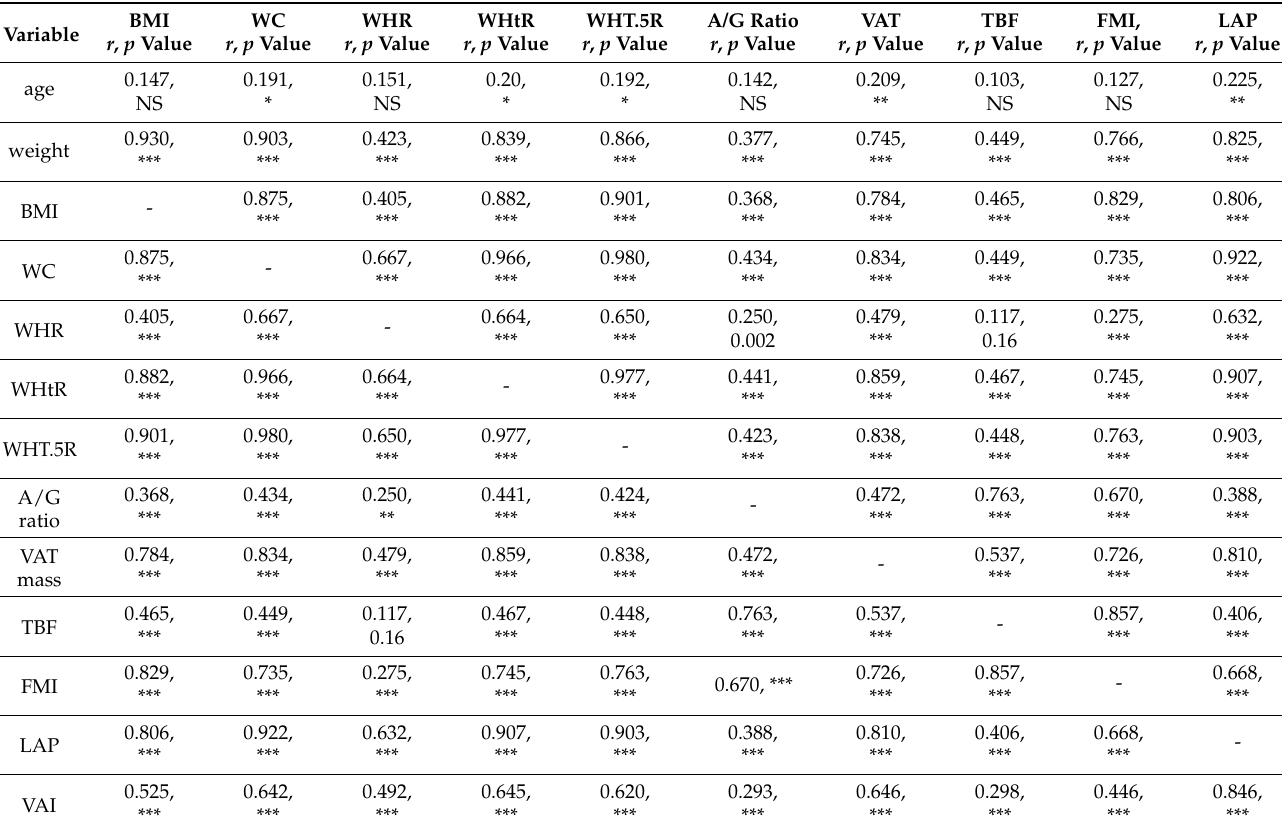
Table 2. Correlation analysis between visceral obesity predictors in PCOS women ( n =